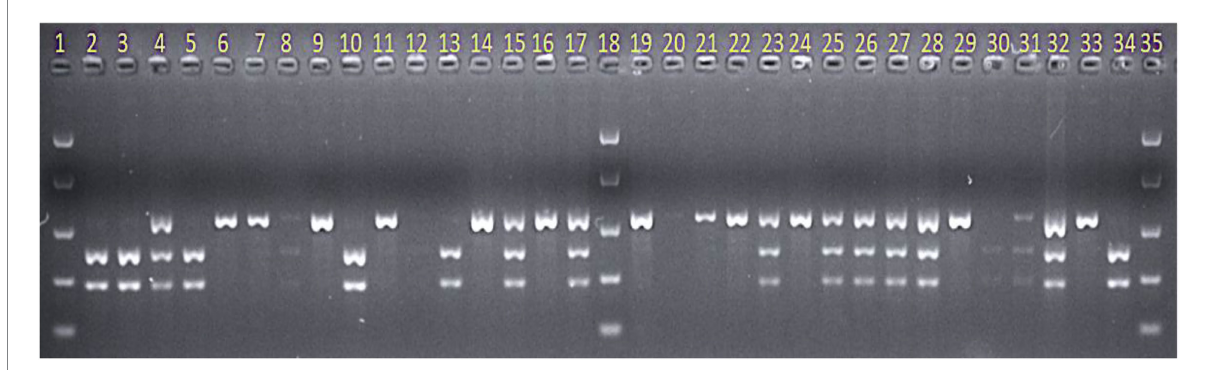
FIGURE 4 Gel image showing screening of the AGG-396/Gus derived F 3 population with CAPS marker Mloc-39 when digested with restriction enzyme MboII. Lane numbers 1, 18, and 35 = Easy Ladder (Bioline). Lane numbers 33 and 34 = resistant parent AGG-396 and susceptible parent Gus, respectively. All other lanes show F 3 progeny from the AGG-396/Gus